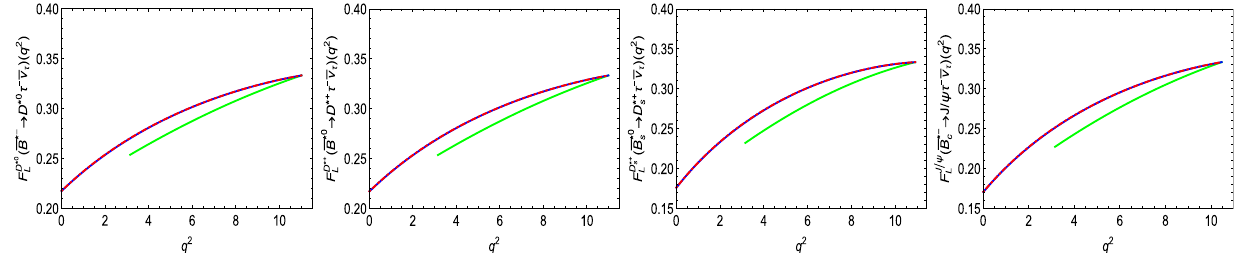
Fig. 4 The hadron polarization fraction F ∗ V